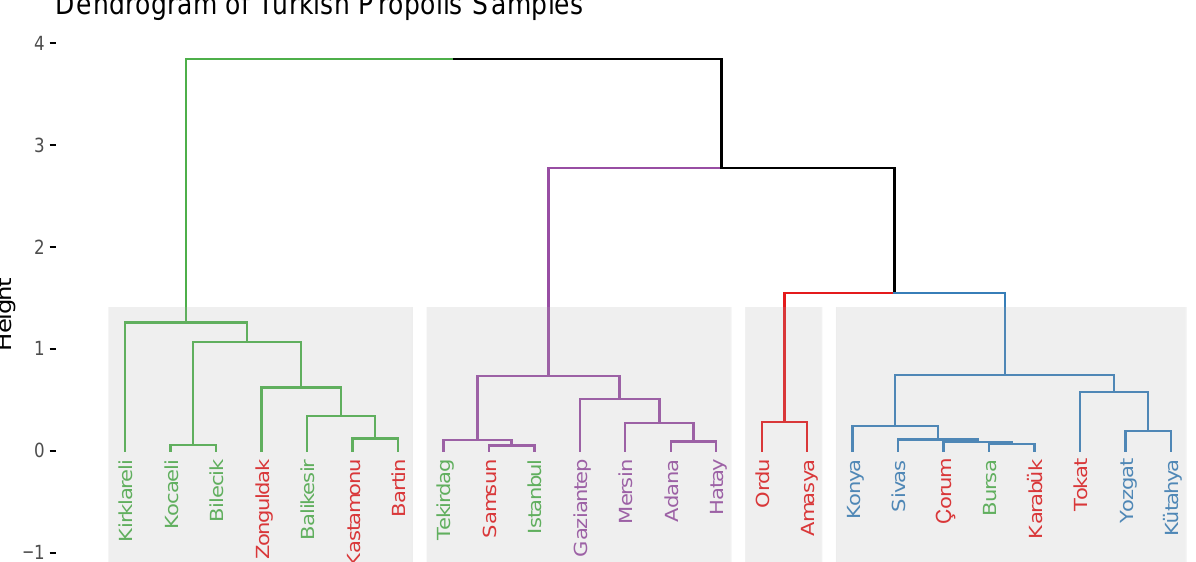
Figure 5. Dendrogram of Turkish propolis samples obtained from the results of HCA by using the factoextra package in R.